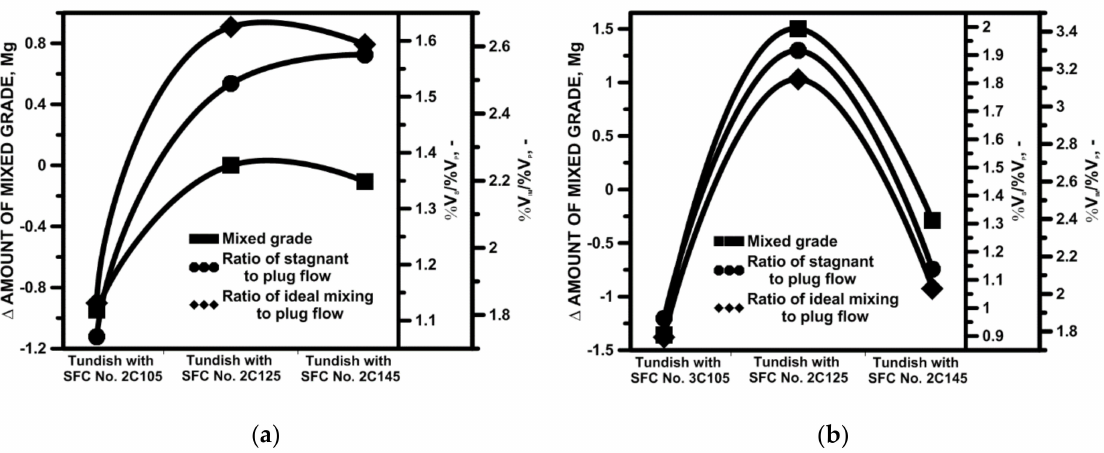
Figure 12. Influence of active flow on transitions grade: ( a ) tundish with SFC No. 2C, ( b ) tundish with SFC No. 3C.